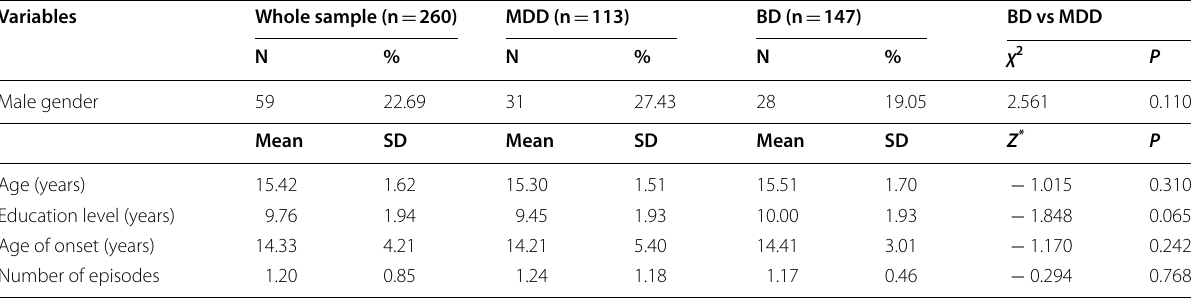
BD bipolar disorder, MDD major depressive disorder, SD standard deviation *